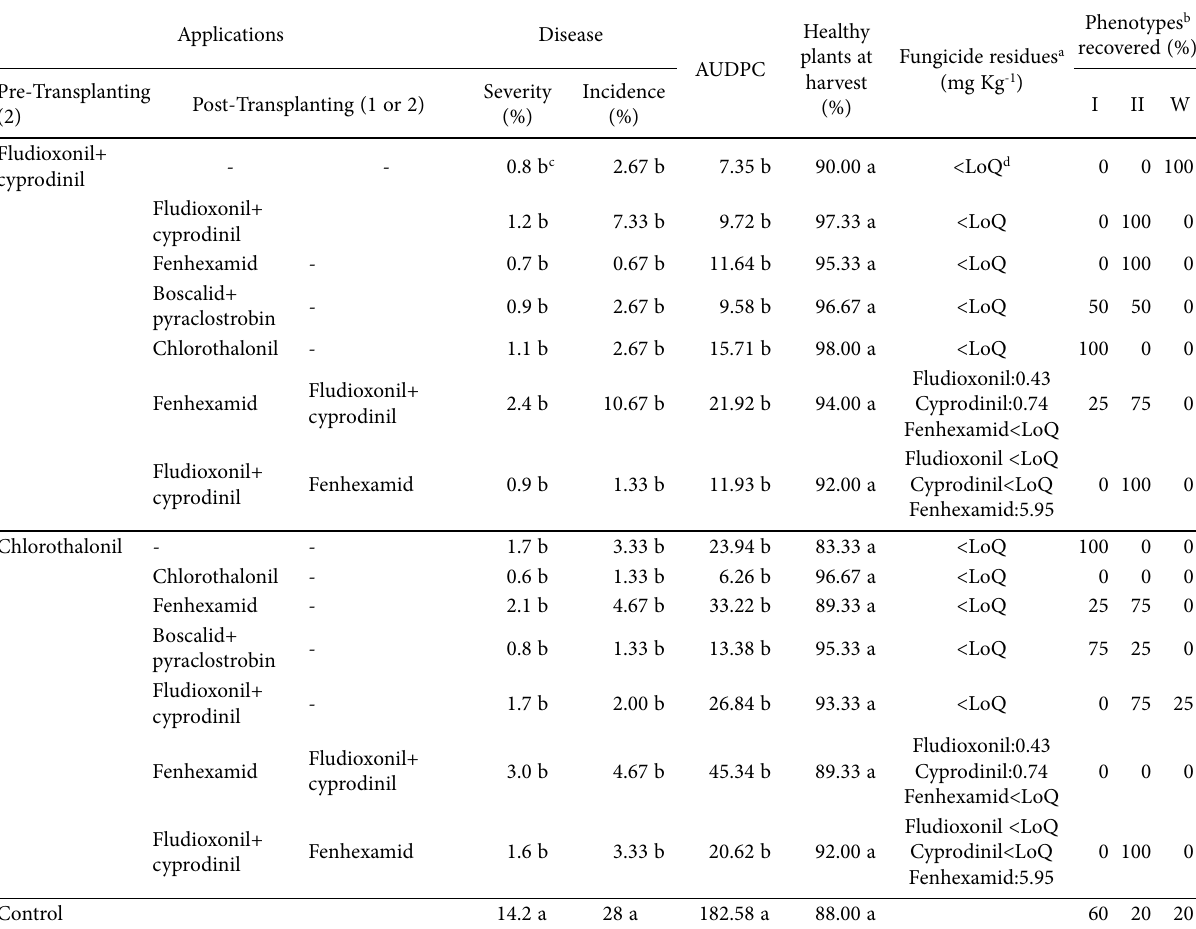
a Maximum residue levels as determined by the European Community. Fludioxonil: 15; Cyprodinil:15; Chlorothalonil: 0.01; Fenhexamid: 40; Boscalid: 30; Pyraclostrobin: 2. b B. cinerea phenotypes: I=QoI R Bos R Ani R Ben HR Dic MR , II=Hyd R QoI R Bos R Ani R Phen MR Ben HR Dic MR , W=Wild type. c Means followed by the same letter in each column do not significantly differ ( P = 0.05, Student-Newman-Keuls). d LoQ: limit of quantification (0.005 mg Kg -1